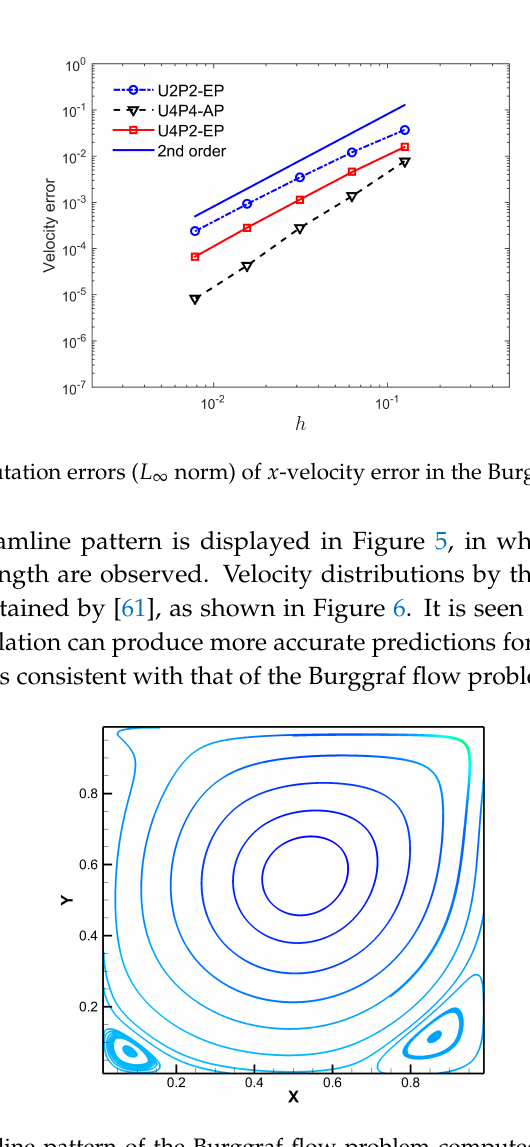
Figure 5. The streamline pattern of the Burggraf flow problem computed by using the U4P2-EP formulation on a 40 × 40 grid.